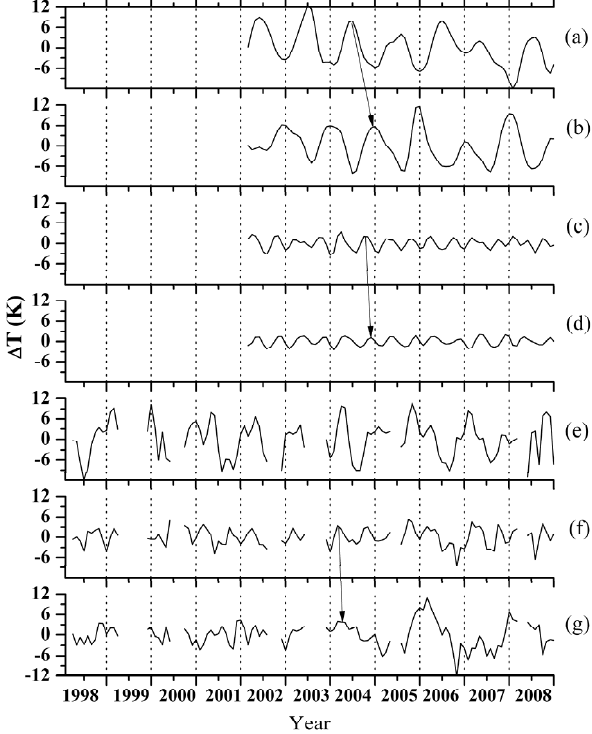
Fig.5. Filtered monthly average Δ T (~ deviation of monthly mean from long term mean Fig. 5. Filtered monthly average 1T ( ∼ deviation of monthly mean from long term mean temperature) after passing through a band pass temperature) after passing through a band pass filter with 10 and 14 months cut off for SABER filter with 10 and 14 months cut off for SABER (a) 90km, (b) 80km (a) 90 km, (b) 80 km and lidar (e) 80 km. The same with a filter of 4 and 8 months cut off, for and lidar (e) 80km. The same with a filter of 4 and 8 months cut off, for SABER (c) 50km (d) 30km and lidar (f) 50km, (g) 30km. The arrows show downward phase